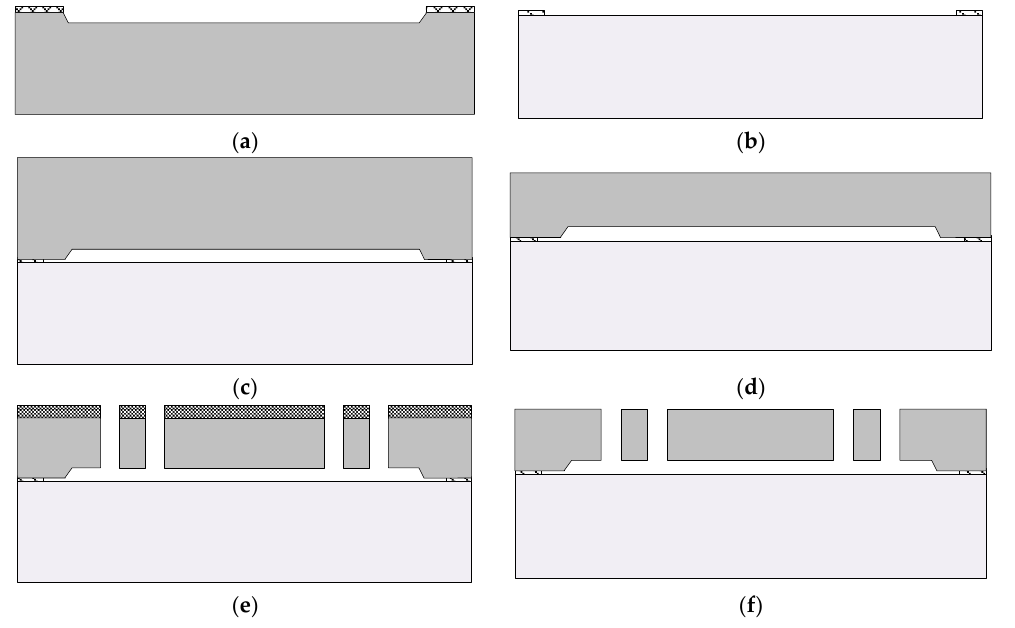
Figure 9. Silicon-on-glass (SOG) fabrication process used to implement the proposed gyroscope. ( a ) Formed anchors on silicon substrate; ( b ) Pattern of Cr/Au at the glass substrate; ( c ) Anodic bonding of silicon and glass substrates; ( d ) CMP of the silicon; ( e ) Pattern of the photoresist etch mask for DRIE and thoroughly etched silicon substrate; and, ( f ) Remove photoresist etch mask.